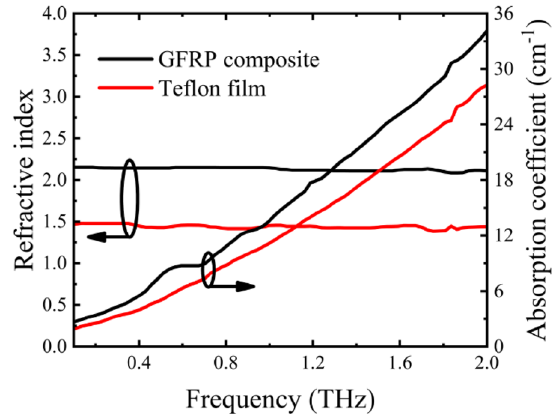
Figure 6 Representation of the optical parameters of the GFRP composite and the Teflon film used to create delamination in its interior: a refractive indices and b absorption coefficients of both